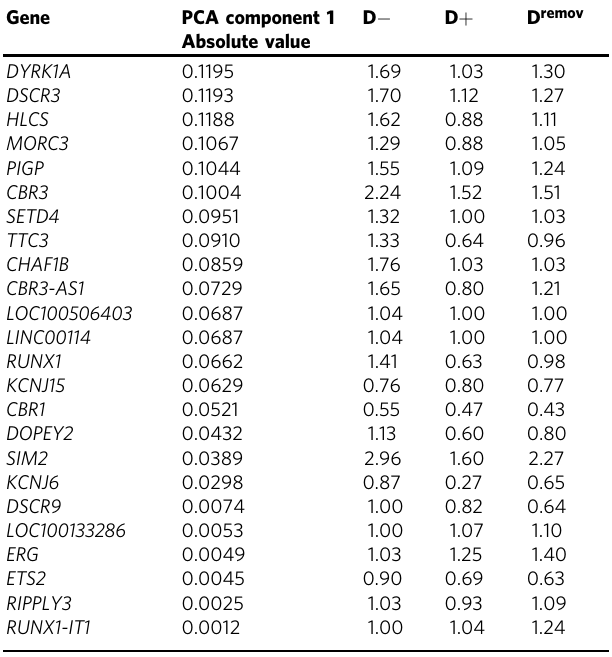
Table. 1 Component score and mean expression of genes located in a 4-Mb region on chromosome